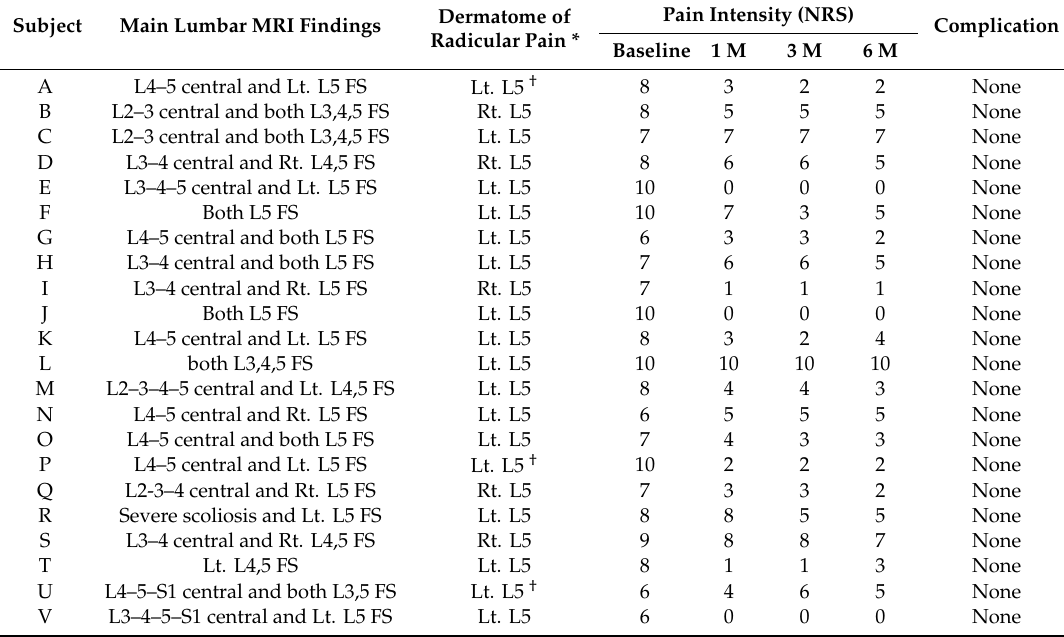
Table 2. Procedural characteristics and outcomes of the study population.